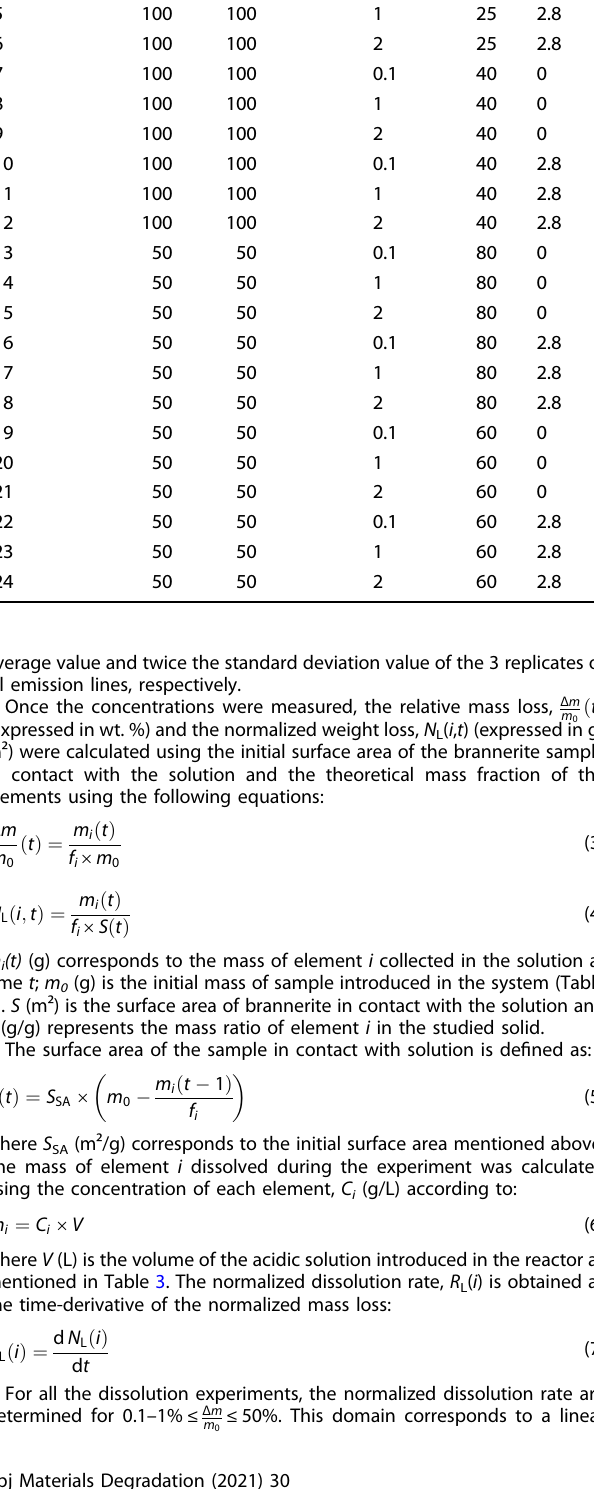
variation of the normalized weight losses unlike the conditions used. Finally, the congruence ratio, R was evaluated as the ratio R L ( U )/ R L ( T i ). Multiparametric expression of the normalized dissolution rate The multiparametric description of the dissolution reaction rate was proposed by Lasaga 48 based on experimental results. In this study, only the in fl uence of the activity of the proton and of the temperature on the dissolution rate of brannerite was considered. Thus, the general form of the rate law was simpli fi ed as follows: